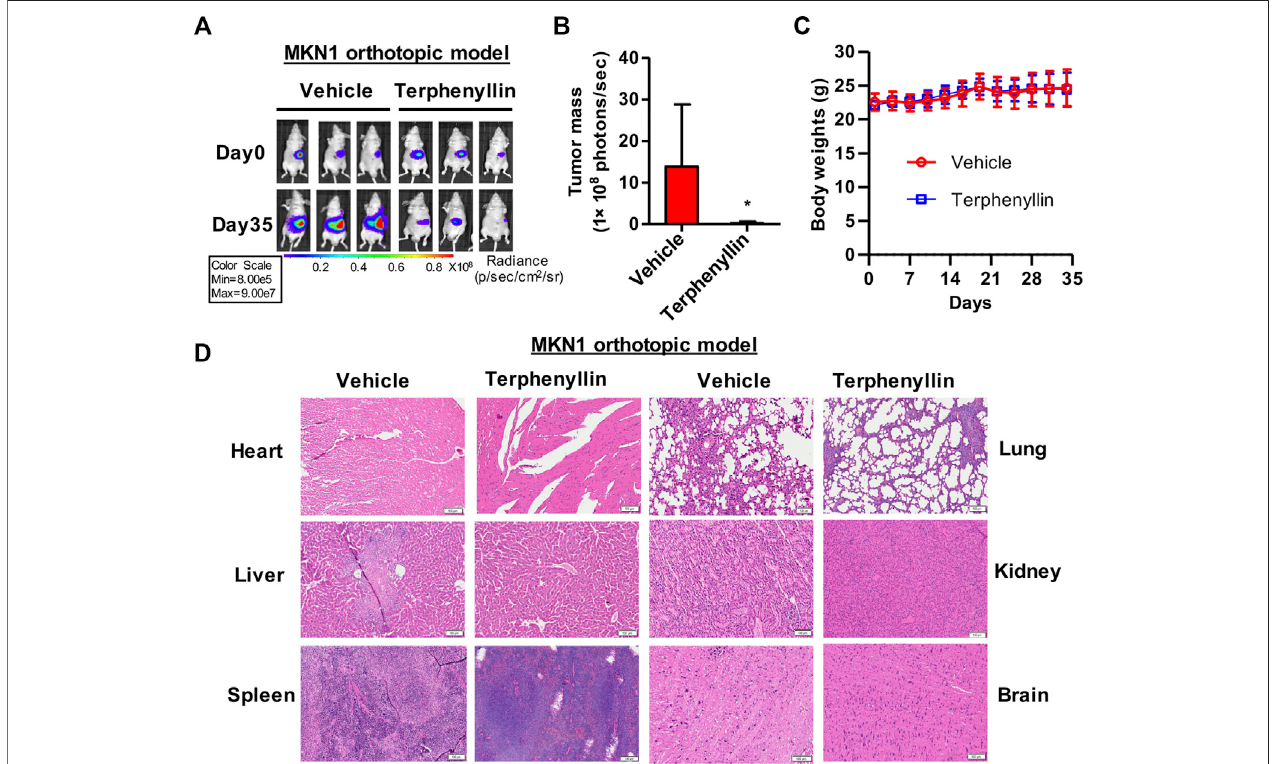
FIGURE5| TerphenyllinsuppressesthegrowthofMKN1orthotopictumorswithoutcausinganyhosttoxicity. (A) TheluciferasesignalofMKN1inmodelmicewas detected every 7 days. (B) At the end of the experiment, the average tumor mass (determined by the detected photons/second) of terphenyllin treated miceand control mice was compared. (C) The weight of mice in the control group and the treated group was monitored every 3 days. (D) At the end of the experiment, samples were taken from the heart, liver, spleen, lung, kidney, and brain of mice, and the paraf fi n sections of these tissues were stained with H&E (all images represent sequence images) sections; scale bar, 100 µm. Results are presented as mean ± SD. ( p p < 0.05; pp p < 0.01, ppp p <